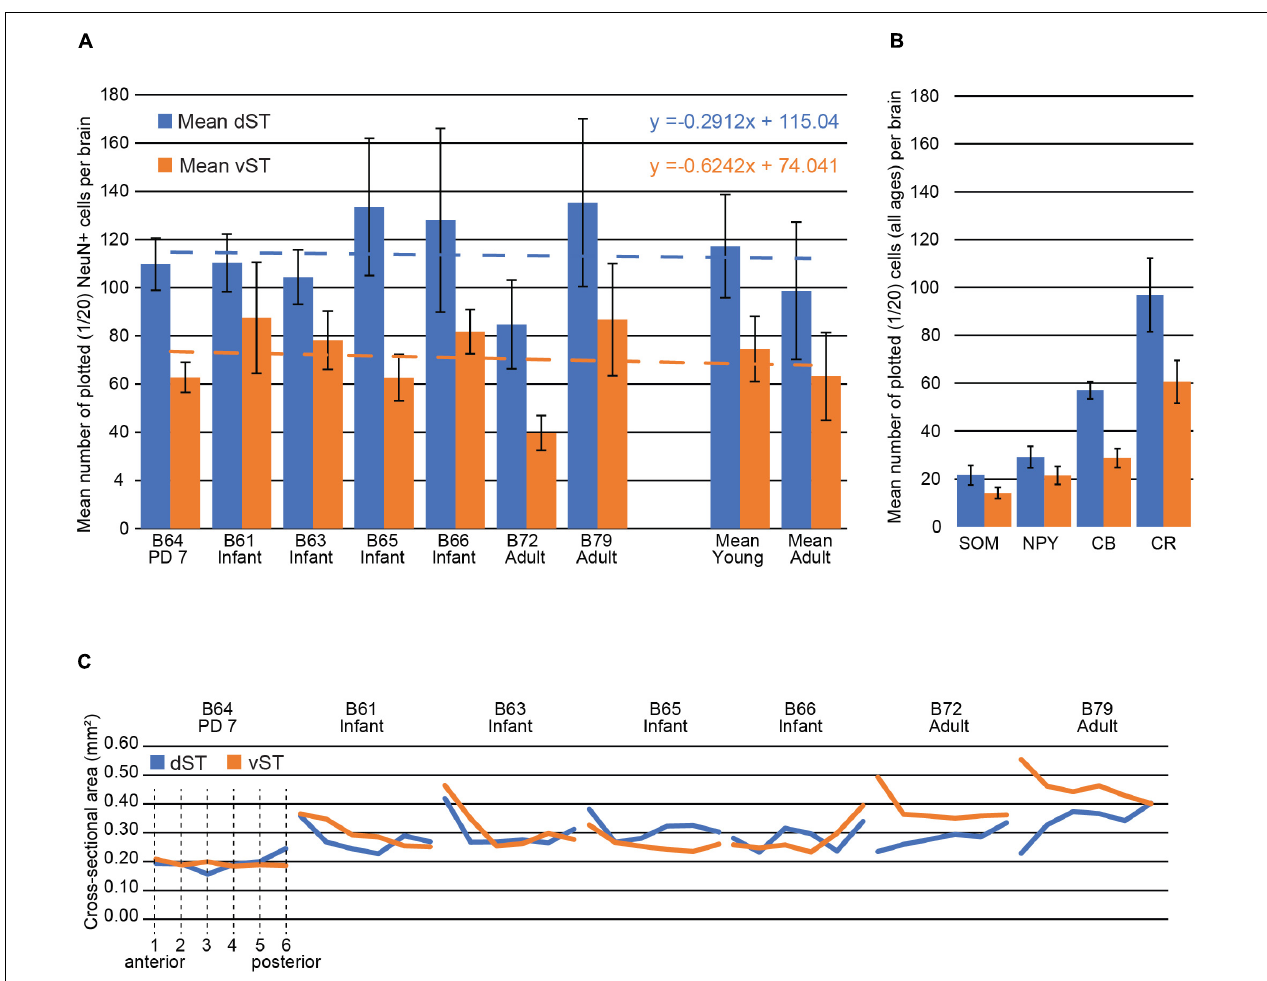
FIGURE 5 | Stria terminalis (ST) cell numbers and ST size (and see Tables 3 , 4 ). (A) Mean number of plotted NeuN + cells in the dST (blue) vs. vST (orange) for one early postnatal brain (P7), four infant brains (2.5 months old), and two adults. The P7 and infant brains have higher average cell counts (see mean numbers at right), and dST counts were consistently higher than vST across all brains. Note that the ratio of the mean number of plotted NeuN + cells in vST vs. dST was strikingly similar in both young and adult brains: The mean number in the vST is 64% of that in the dST. The mean percent decrease in the number of cells from young to adult in both the dST and vST was 15%, but this measure is heavily skewed by B72. Best fit lines for the mean dST and vST are almost parallel indicating a high degree of confidence in this measure. Error bars are SEM. (B) The mean number of plotted, immunohistochemically identified cells for SOM, NPY, CB, and CR for all brains, at a sampling rate of 1/20 sections. With the numbers in the dST representing 100%, the corresponding ratios in the vST are 65.6% (SOM), 73.5% (NPY), 50.4% (CB), and 62.5% (CR). The most numerous subpopulation is that positive for CR and the least numerous, the subpopulation positive for SOM. (C) The dST and vST areas, measured in NeuN-stained material, are shown from the anteriormost section (1) to the posteriormost section in the ROI (6) for each of the brains. Areas here are provided in mm 2 for convenience (see Table 4 for further